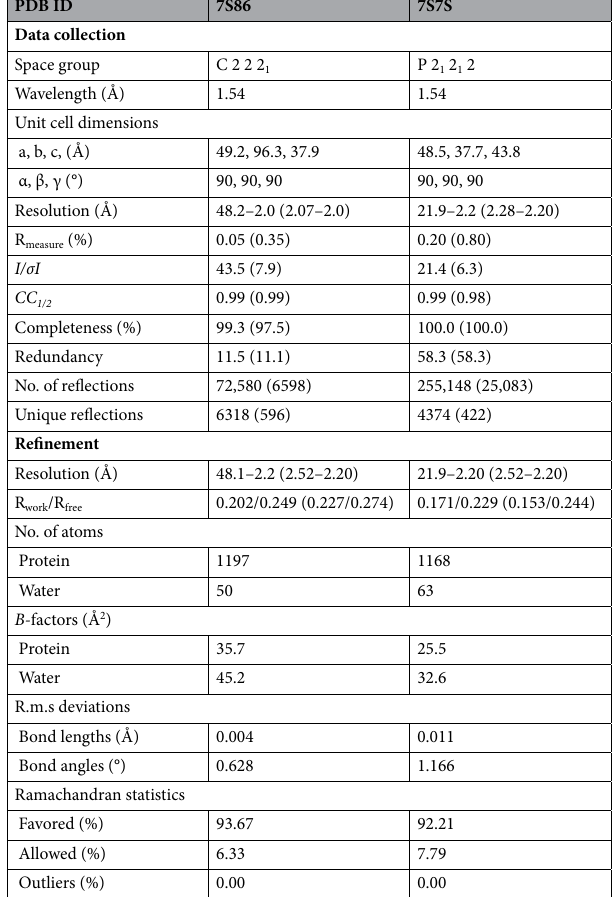
Table 1. X-ray diffraction data collection and refinement